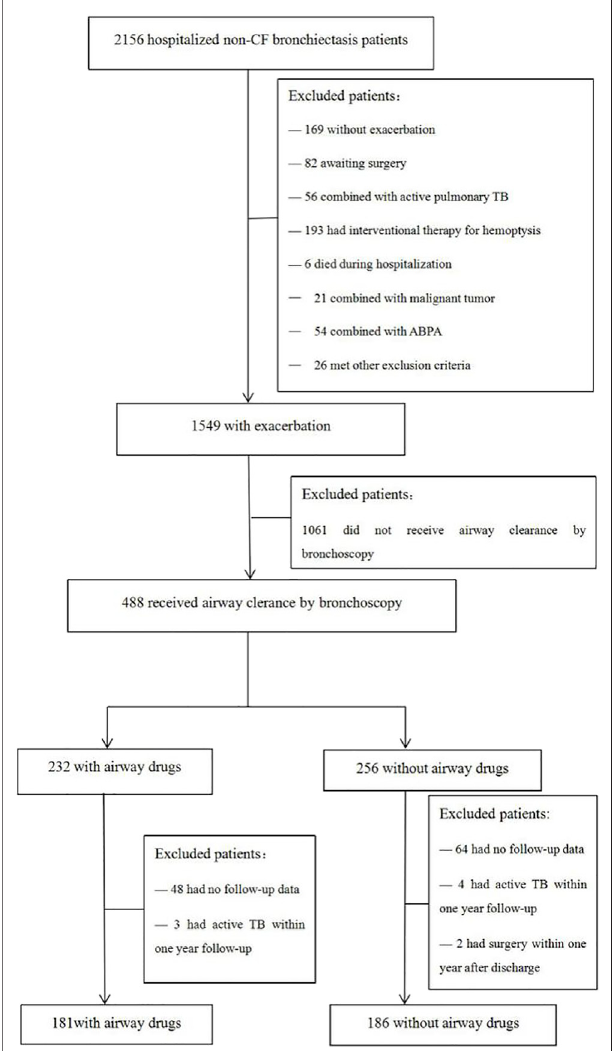
FIGURE1 | Flow chartofthestudy. CF, cystic fi brosis; TB,tuberculosis; ABPA, allergic bronchopulmonary